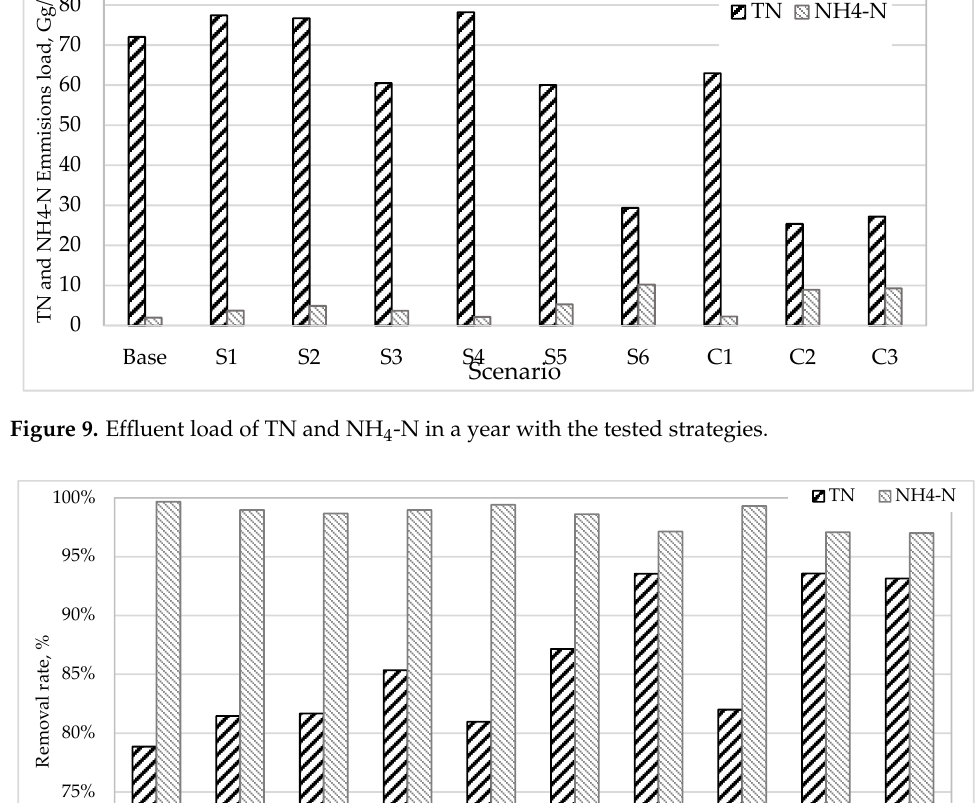
Figure 9. Effluent load of TN and NH 4 -N in a year with the tested strategies.